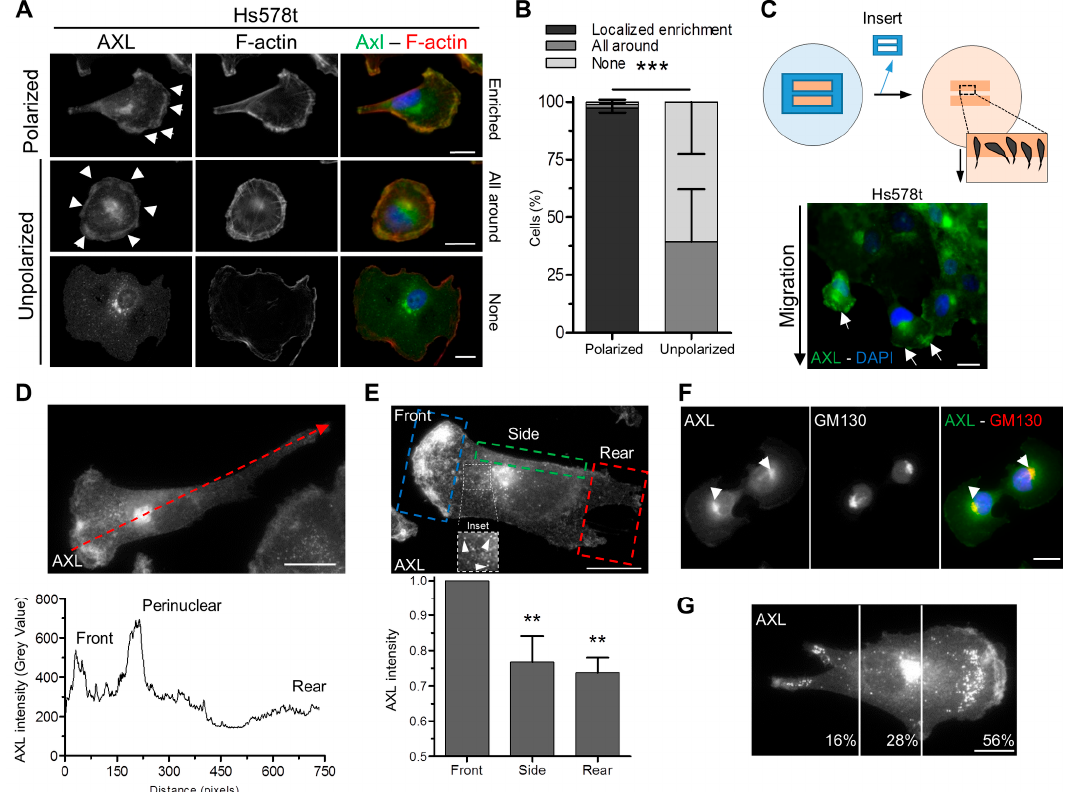
Figure 2. Polarized localization of AXL in migrating cells. ( A ) Staining of AXL (green) and F-actin (red) in polarized or unpolarized Hs578t cells. “All around” defines cells with AXL enriched all along the plasma membrane; “None” defines cells without AXL at the plasma membrane. Arrowheads point to AXL enriched staining at the plasma membrane. ( B ) Frequency of polarized (left column) or unpolarized (right column) Hs578t cells (%) displaying or not an enrichment of AXL at the plasma membrane (localized enrichment, all around) from the analysis of 211 cells in three independent experiments. (*** p < 0.001). ( C ) Upper panel: schematic representation of a wound healing experiment. Lower panel: AXL staining (green) in Hs578t cells six hours after wound healing. Arrows point to AXL enrichment at the front of migrating cells. ( D ) Linescan of AXL intensity (grey value) of Hs578t cells (following the dashed red arrow on the top image). ( E ) AXL intensity at the lateral area and at the rear of Hs578t cells relative to the front obtained from 42 cells in four independent experiments. (** p = 0.008; 0.0011). Arrowheads in inset point to AXL-stained structures. ( F ) AXL (green) and GM130 (red) staining of Hs578t cells. Arrowheads point to AXL staining at the perinuclear area. ( G ) Percentage of AXL-rich vesicles in polarized cells depending on their localization obtained from 20 cells in two independent experiments. Scale bars, 20 µ m. All graphs represent means and small bars indicate standard deviation.